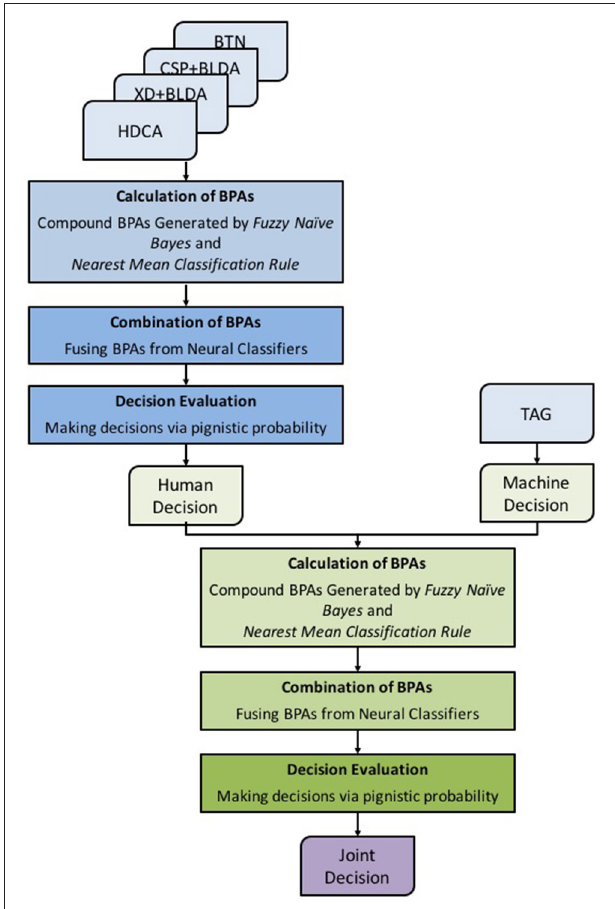
FIGURE 3 | Framework of the Fuzzy Decision-Making